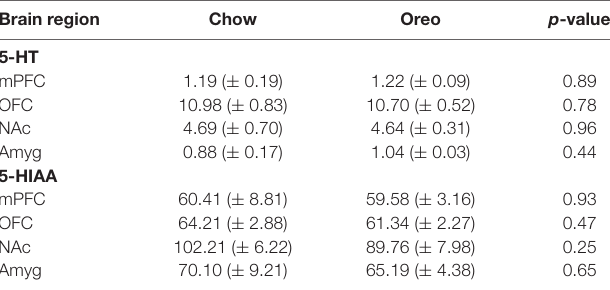
TABLE 2 | Effect of patterned feeding of HPF on 5-HT and 5-HIAA levels in the brain reward circuitry. Brain region Chow Oreo p -value